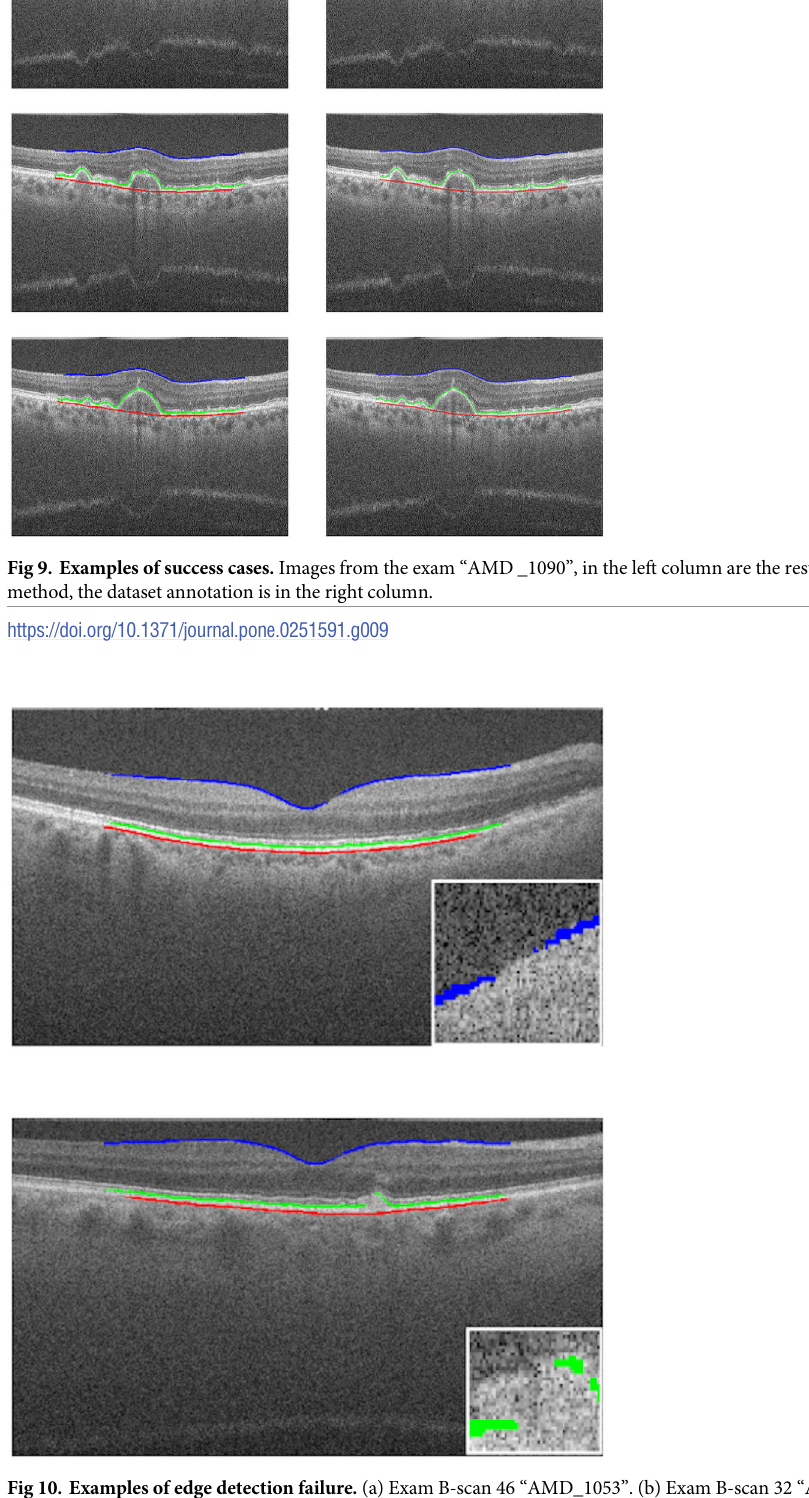
PLOS ONE | https://doi.org/10.1371/journal.pone.0251591 May 14, 2021 12 /